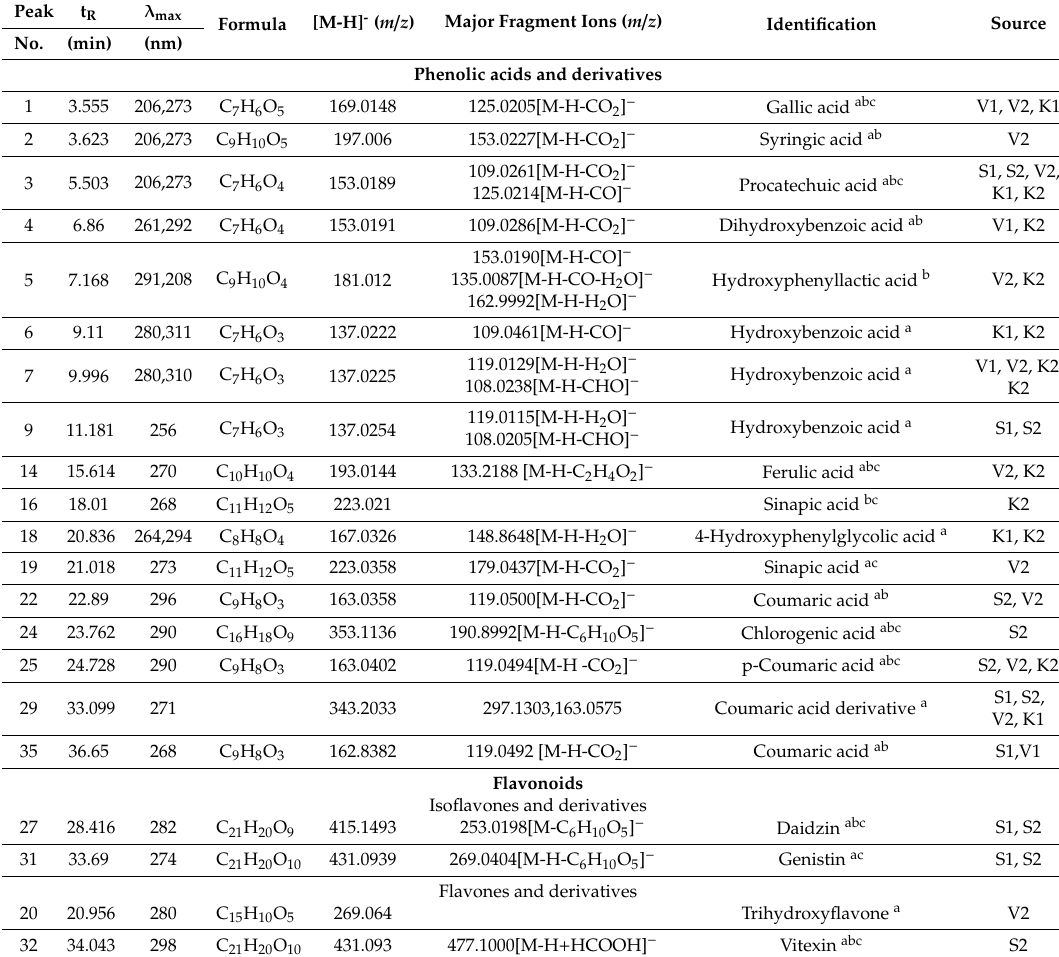
Figure 1. Base peak chromatogram (BPC) of bound phenolics in legumes. ACB-S: acid hydrolysis-bound phenolicsofsoybean;ALB-S:alkalinehydrolysis-boundphenolicsofsoybean;ACB-V:acidhydrolysis-bound phenolics of vicia faba; ALB-V: alkaline hydrolysis-bound phenolics of vicia faba; ACB-K: acid hydrolysis- bound phenolics of kidney bean; ALB-K: alkaline hydrolysis-bound phenolics of kidney bean. Table 2. Characterization of the bound phenolic constituents of legumes by UPLC-ESI-QTOF-MS2.